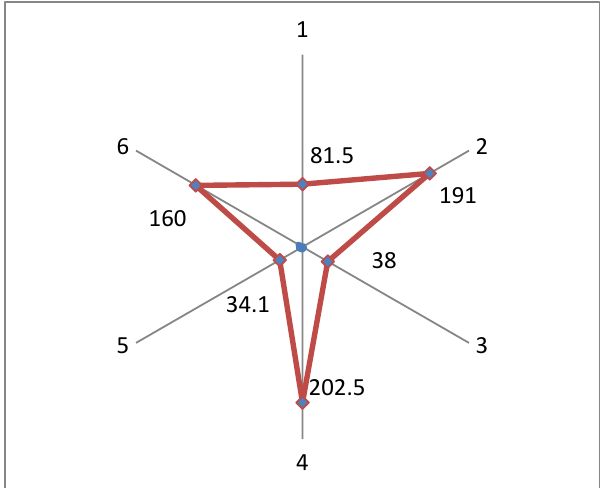
Fig.1. Averaged model of cardio-vascular and respiratory systems’ indicators of elite sportsmen, specialized in kinds of sports, connected with endurance [12,